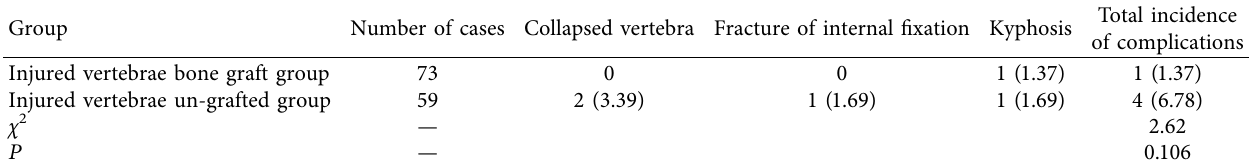
Table 6: Comparison of postoperative complications between the two groups ( n , %). Group